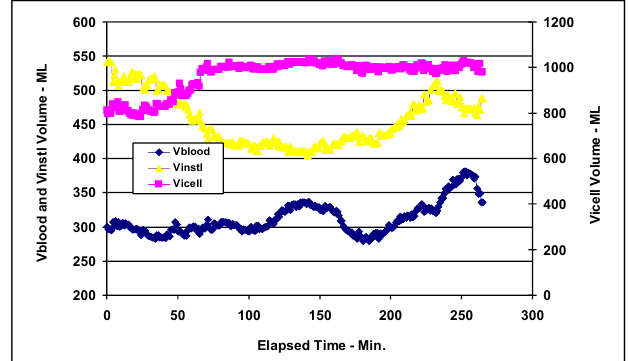
Fig. 8: Resusitation NET FLUID vs. elapsed time.